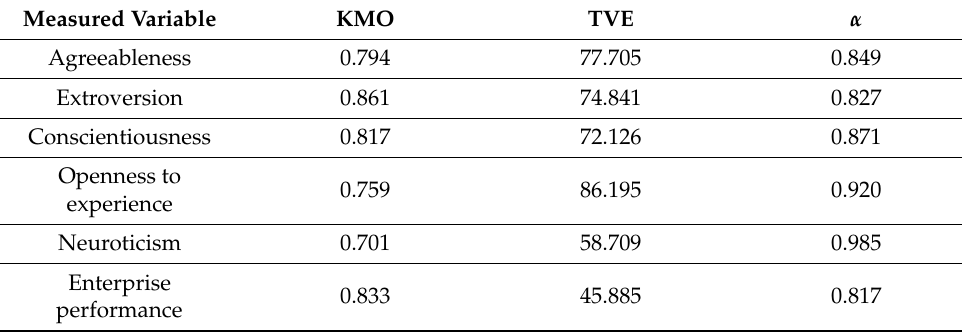
Table A2. KMO, Total Variance Explained and Cronbach